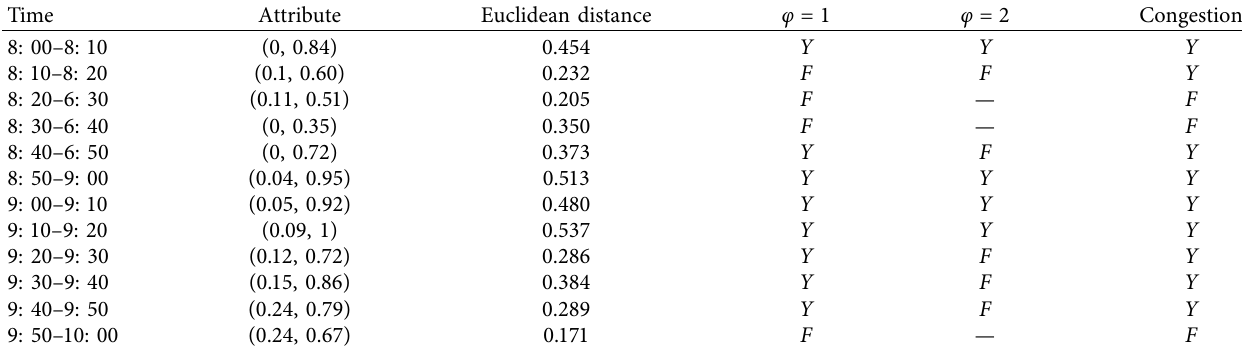
Table 4: An example of the calculation result (satisfies equations (4), (7), and (8)) of traffic status discrimination in grid (1, 5). Time Attribute Euclidean distance φ � 1 φ � 2 Congestion